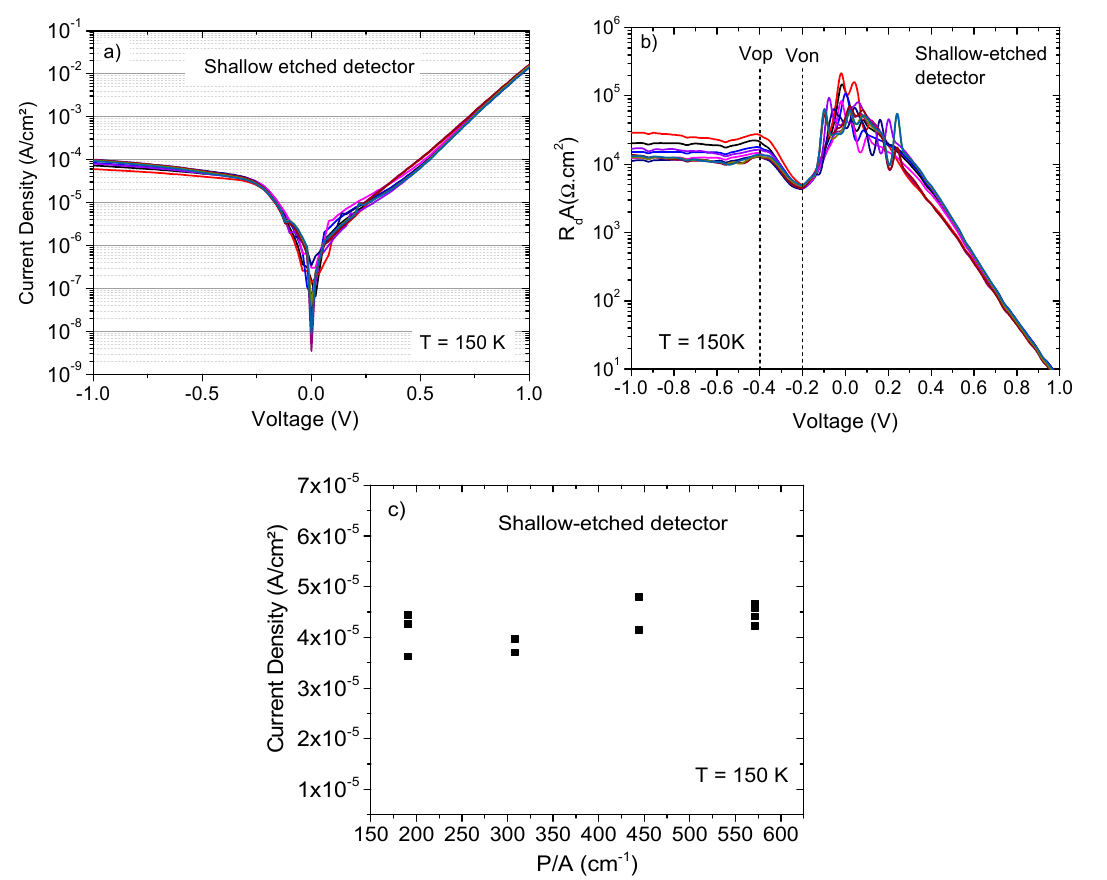
Figure 5. Shallow-etched photodetectors: ( a ) dark current density voltage characteristics performed on different detector sizes at 150 K; ( b ) differential Resistance Area product (R d A) product as a function of the voltage at 150 K; ( c ) dark current density value as a function of the perimeter to area ratio (P/A), extracted at V op = − 400 mV.